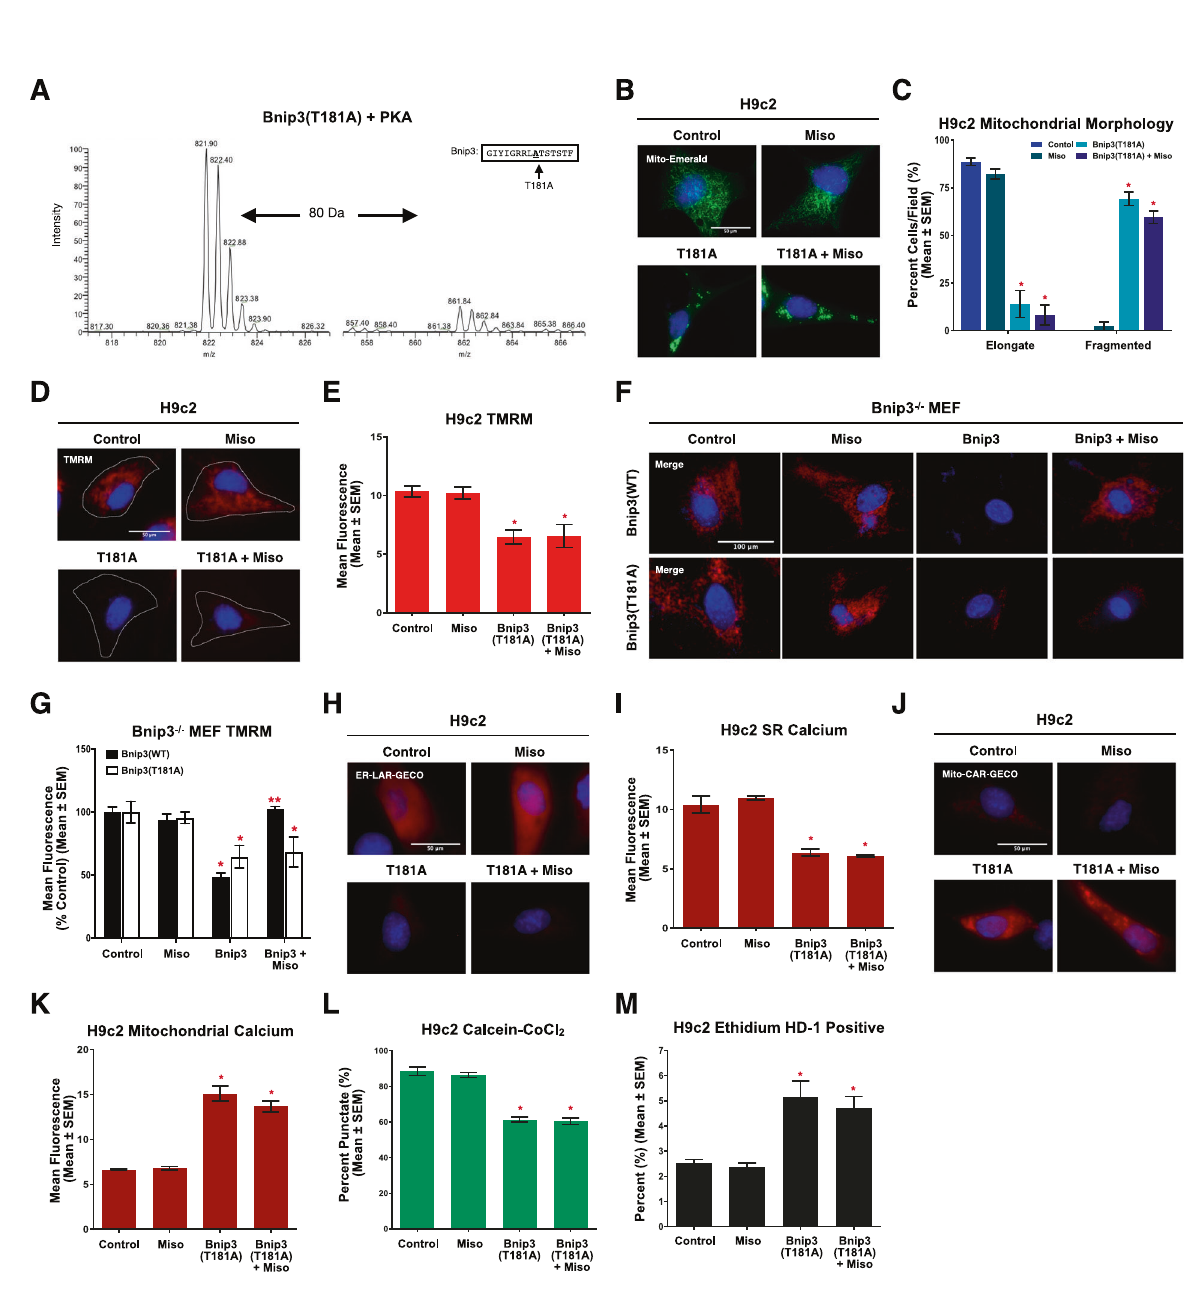
Fig. 4 Misoprostol stimulates EP4 receptors to activate PKA and promote the modulation of a novel PKA phosphorylation site on Bnip3 at Thr-181 in cells and the PND10 neonatal heart. A Mitochondrial calcium retention capacity (CRC) in isolated mitochondria exposed to 10 μ M misoprostol (Miso) or PBS control. B Mitochondrial swelling assay in isolated mitochondria treated as in ( A ). C H9c2 cells exposed to 1% O 2 (HPX) or 21% O 2 (control) and treated with 10 μ M misoprostol (Miso) or PBS control for 24h. 10 μ M L161,982 was also included in half of the conditions. Cells were stained with TMRM (red) and hoechst (blue) and imaged by standard fl uorescence microscopy. D Quanti fi cation of cells in ( C ), where red fl uorescent signal was normalized to cell area and quanti fi ed in 30 random fi elds, across 3 independent experiments. E H9c2 cells treated, stained and imaged as in ( C ). 1 μ M L798106 was also included in half of the conditions. F Quanti fi cation of cells € ( E ), as in ( D ). G Quanti fi cation of H9c2 cells treated as in ( C ) with the addition of 10 μ M H-89 for 24 h. Cells were imaged as in ( C ) and quanti fi ed as in ( D ). H SIM scan of the wild- type peptide spanning the PKA site of Bnip3. The unphosphorylated peptide has a 837 m/z (z = 2 + ) (Left), putative phosphorylation showing an increased m/z of 40 that corresponds to PO 3 (M = 80.00Da) (Right). I MS 2 spectra following collision induced dissociation (CID) of the mass shifted ion from ( H ) yielding a product-ion consistent with a neutral loss of H 3 PO 4 . J MS 2 spectra following electron transfer dissociation (ETD) of a triply charged mass-shifted ion following kinase reaction (not shown). Analysis of this fragmentation spectra con fi rmed that threonine-181 is the preferred phosphorylation residue. K Alignment of evolutionarily conserved T181 phosphorylation site (bold and underlined), and 14-3-3 binding motifs (Red) for Bnip3 in human, mouse and rat. L Immunoblot of H9c2 cells transfected with Myc-Bnip3 and/or PKA for 16h. M Representative immunoblot of heart protein extracts from post-natal day (PND10) mice exposed to hypoxia (10% O 2 ) ± 10 μ g/kg misoprostol from PND3-10. Extracts were immunoblotted as indicated. N Phospho-Bnip3 densitometry for extracts in ( M ), representing an N of 3 male PND10 mouse hearts. All data are represented as mean ± S.E.M. *P < 0.05 compared with control, while **P < 0.05 compared with hypoxia treatment, determined by 1-way ANOVA or 2-way ANOVA where